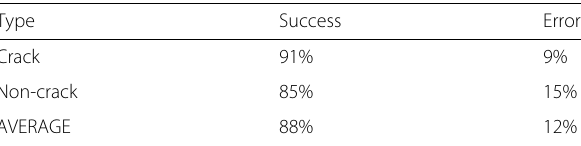
Table 4 Crack detection error